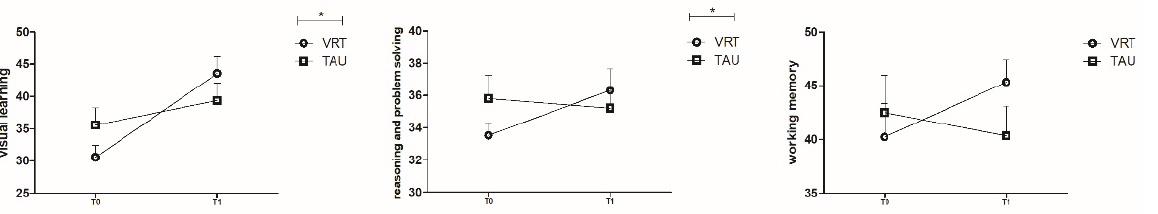
Figure 3. Legends: Figure 3 Line chart showing the changes of ViL, RPS and WM T scores between T0 (VRT: 30.57 ± 10.21, 30.57 ± 10.21 and 40.23 ± 17.08; TAU: 35.56 ± 15.19, 34 (30.25, 42)) and 42.50 ± 19.78 and T1 (VRT: 30.57 ± 10.21, 30.57 ± 10.21 and 45.33 ± 11.18; TAU: 35.56 ± 15.19, 34 (30.25, 42) and 40.34 ± 15.68), p = 0.002, 0.001, 0.086, respectively, * p ≤ 0.007).